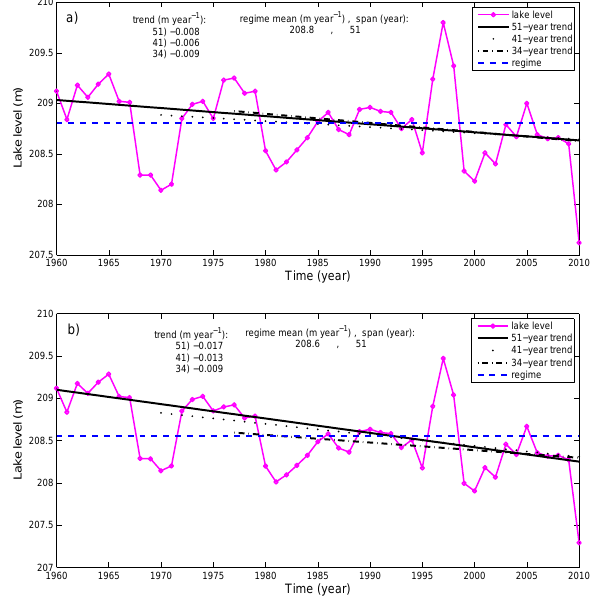
Fig. 9. Level of Lake Athabasca (original) and the detected trends Fig.9. LeveloftheLakeAthabasca(original)andthedetectedtrendsbasedona)originalrecordeddatanearCrackingstonePointandb) dataadjustedtoaccountfortheartificialincreaseinrecordedlevels.Thesignificancelevel( p -values)arelessthan0.02fortheadjustedlake based on (a) original recorded data near Crackingstone Point and levelforanalysisperiodsof41yearsand51years. (b) data adjusted to account for the artificial increase in recorded levels. The significance levels ( p values) are less than 0.02 for the adjusted lake level for the analysis periods of 41yr and